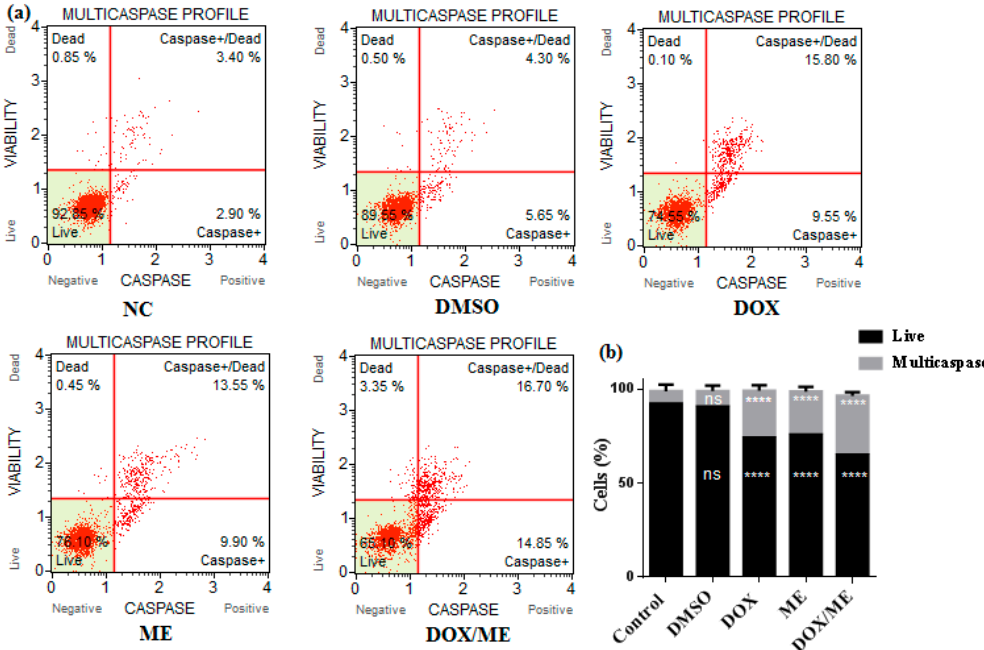
Figure 5. Activation assays of Multicaspase enzyme. ( a ) The plots illustrate the effect induced by the treatment with Dox (IC 50 ) or ME (IC 50 ) or ME (IC 10 ) combined Dox (IC 50 ) in the Caco-2 cell line after 24h. Each plot is a representative determination figure of the three replicates. ( b ) The bar charts depict the percentage of live cells and multicaspase enzyme activation. Data represent the mean ± standard deviation of the mean of 3 independent experiments; ns (not significant), **** p < 0.0001 compared to the untreated DMSO control by one-way ANOVA.